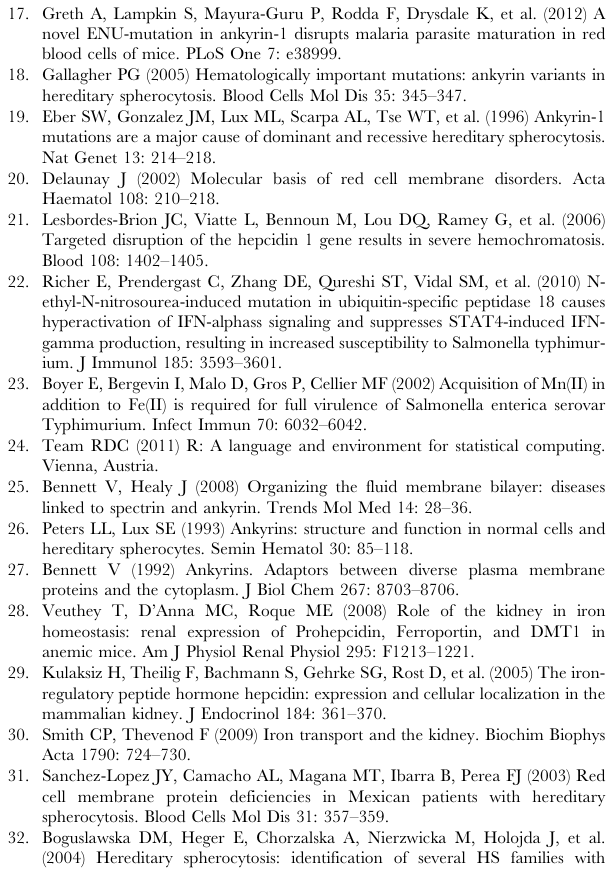
Figure S1 Histopathologic examination of the spleen, liver and kidney of 7 week old ANK1 + / + wild type, ANK1 + /Ity16 heterozygous, and ANK1 Ity16/Ity16 mutant mice before infection (day 0). H&E stain of uninfected spleen of wild type (A), heterozygous (E), and Ity16 mutants (I). Prussian blue stain of uninfected spleen, liver and kidney, respectively, of wild type (B,C,D), heterozygous (F,G,H), and Ity16 mutants (J,K,L). All pictures are taken at 200 6 magnification. RP = red pulp, WP=white pulp. Figure S2 Progression of lesions in kidney and liver 2 days after Salmonella infection of ANK1 + / + wild type, ANK1 + /Ity16 heterozygous, and ANK1 Ity16/Ity16 mutant mice aged 7 and 24 weeks using hematoxylin & eosin staining. H&E stain of uninfected kidney of wild type (A,B), heterozygous (E,F), and Ity16 mutants (I,J) at 7 and 24 weeks of age respectively. H&E stain of day 2 post infection liver of wild type (C,D), heterozygous (G,H), and Ity16 mutants (K,L) at 7 and 24 weeks of age respectively. All pictures taken at 200 6 magnifi- cation. Figure S3 Prussian blue staining of liver and kidney of 7 week old ANK1 + / + wild type and ANK1 + /Ity16 heterozy- gous mice at day 2 and day 6 post infection with Salmonella Typhimurium. Prussian blue stain of day 2 post infection liver in wild type (A) and heterozygous (D) mice at